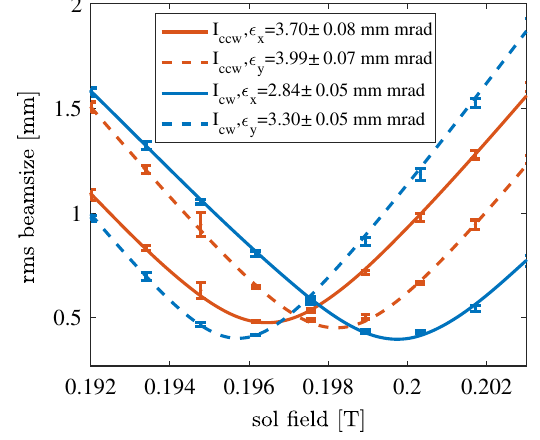
FIG. 9. Solenoid scan experiment data. rms beamsize as a function of the solenoid field strength and fitted emittances taken during the solenoid scan experiment.